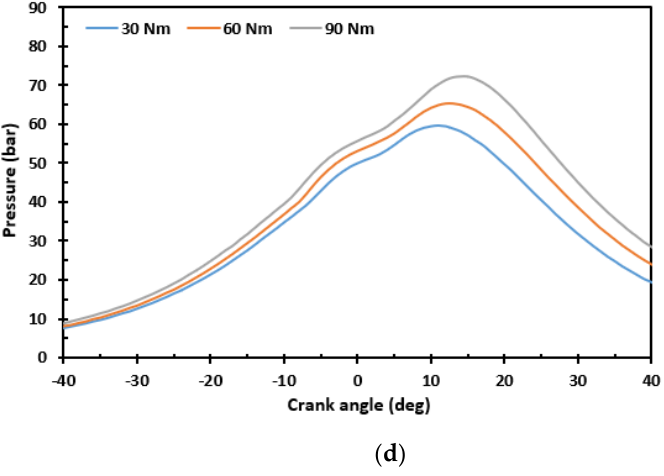
Figure 2. In-cylinder pressure for ( a ) D100, ( b ) D95E5, ( c ) D90E10, and ( d ) D85E15.